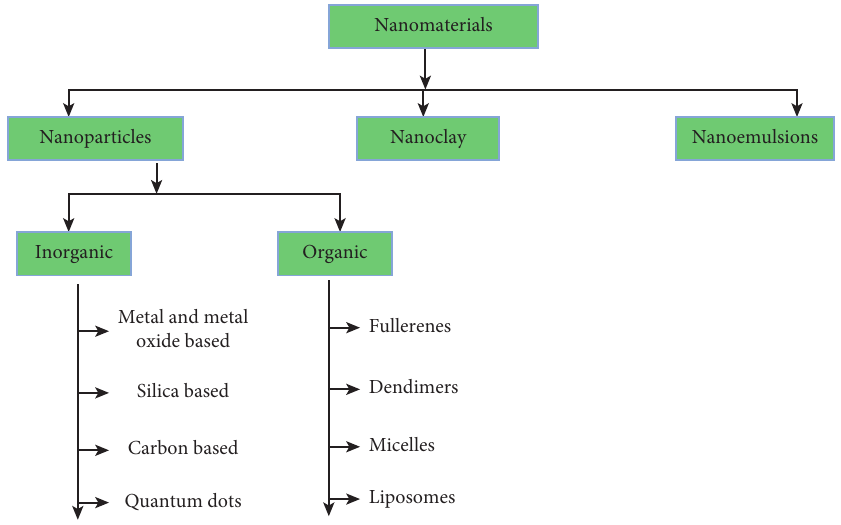
Figure 3: Classification of nanomaterials. Created using